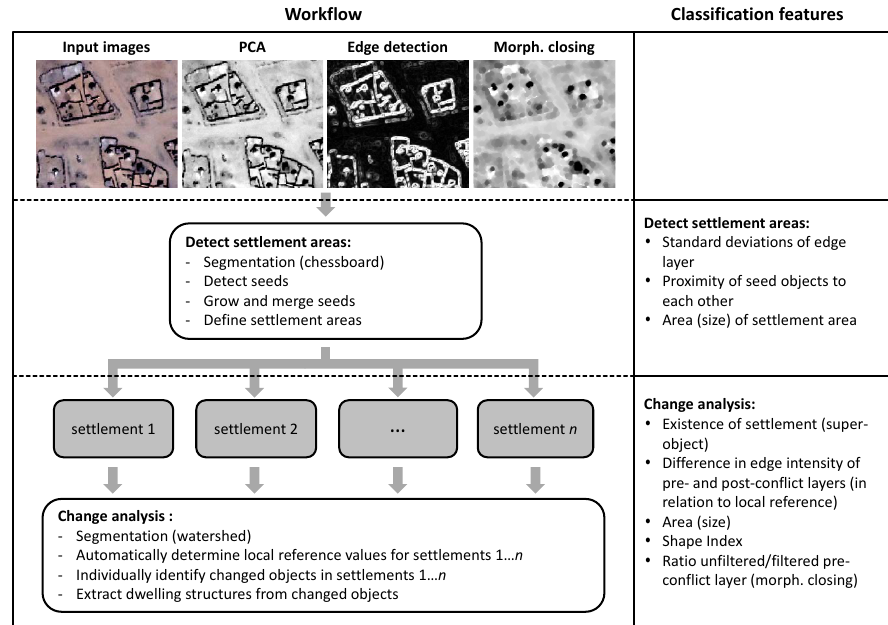
Figure 2. Overview of the example analysis workflow. It shows the key analysis steps on the left and the applied features for the object-based change detection and classification on the right. The first row shows the input images and image processing results created in the first step of the workflow and used as input for the object-based analysis in the subsequent steps (modified after